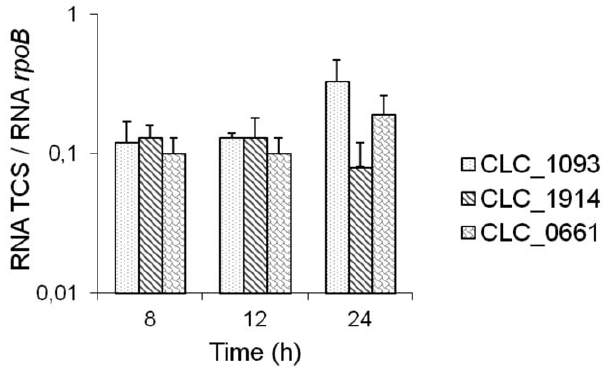
Figure 8. Kinetics of transcript levels of CLC_1093, CLC_1914, and CLC_0661 in Hall strain. Transcript levels were quantified by qRT-PCR and normalized versus rpoB gene. Data are mean values + / 2 SD, from 3 independent experiments.